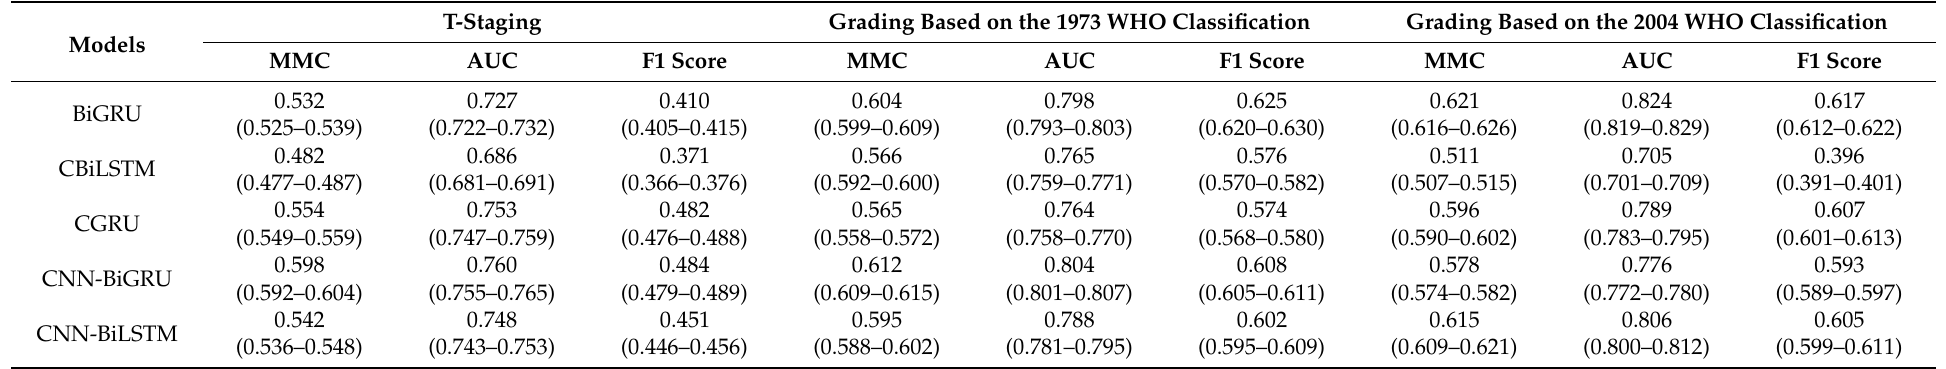
Table 2. Performance of each model on validation data. MMC, Matthews correlation coefficient; AUC, area under the curve; WHO, World Health Organization. The 95% confidence intervals are shown in